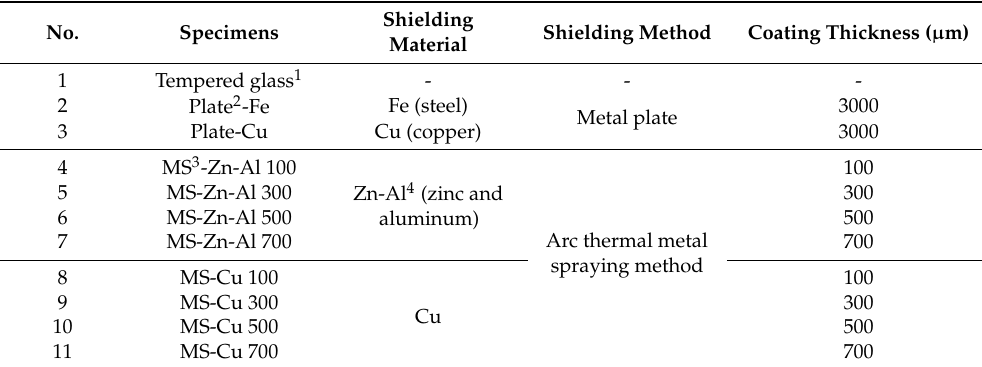
Table 2. List of specimens for the SE